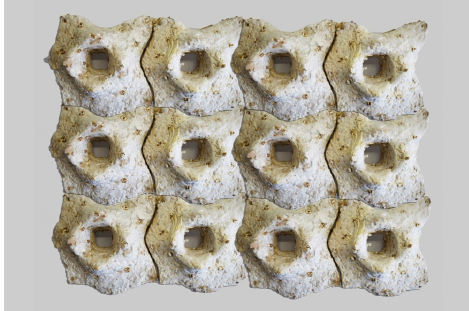
Figure 13. Modular system out of hard shell templated elements.